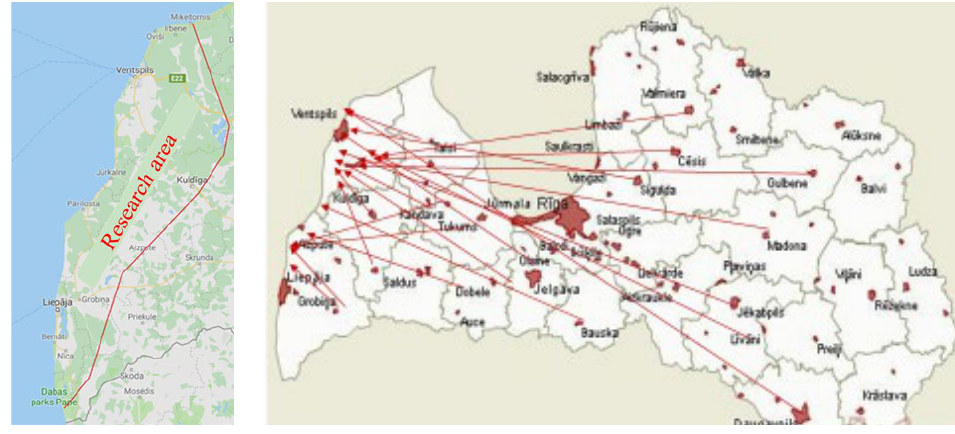
Fig. 3. Research area and place of residents of